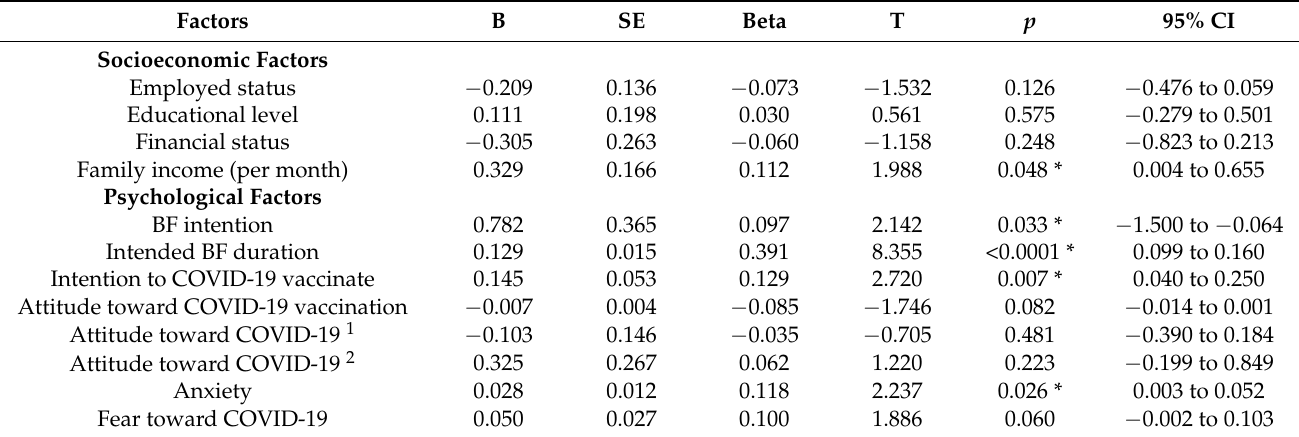
Table 2. Socioeconomic and psychological factors affecting of breastfeeding duration in the first year of life ( n =